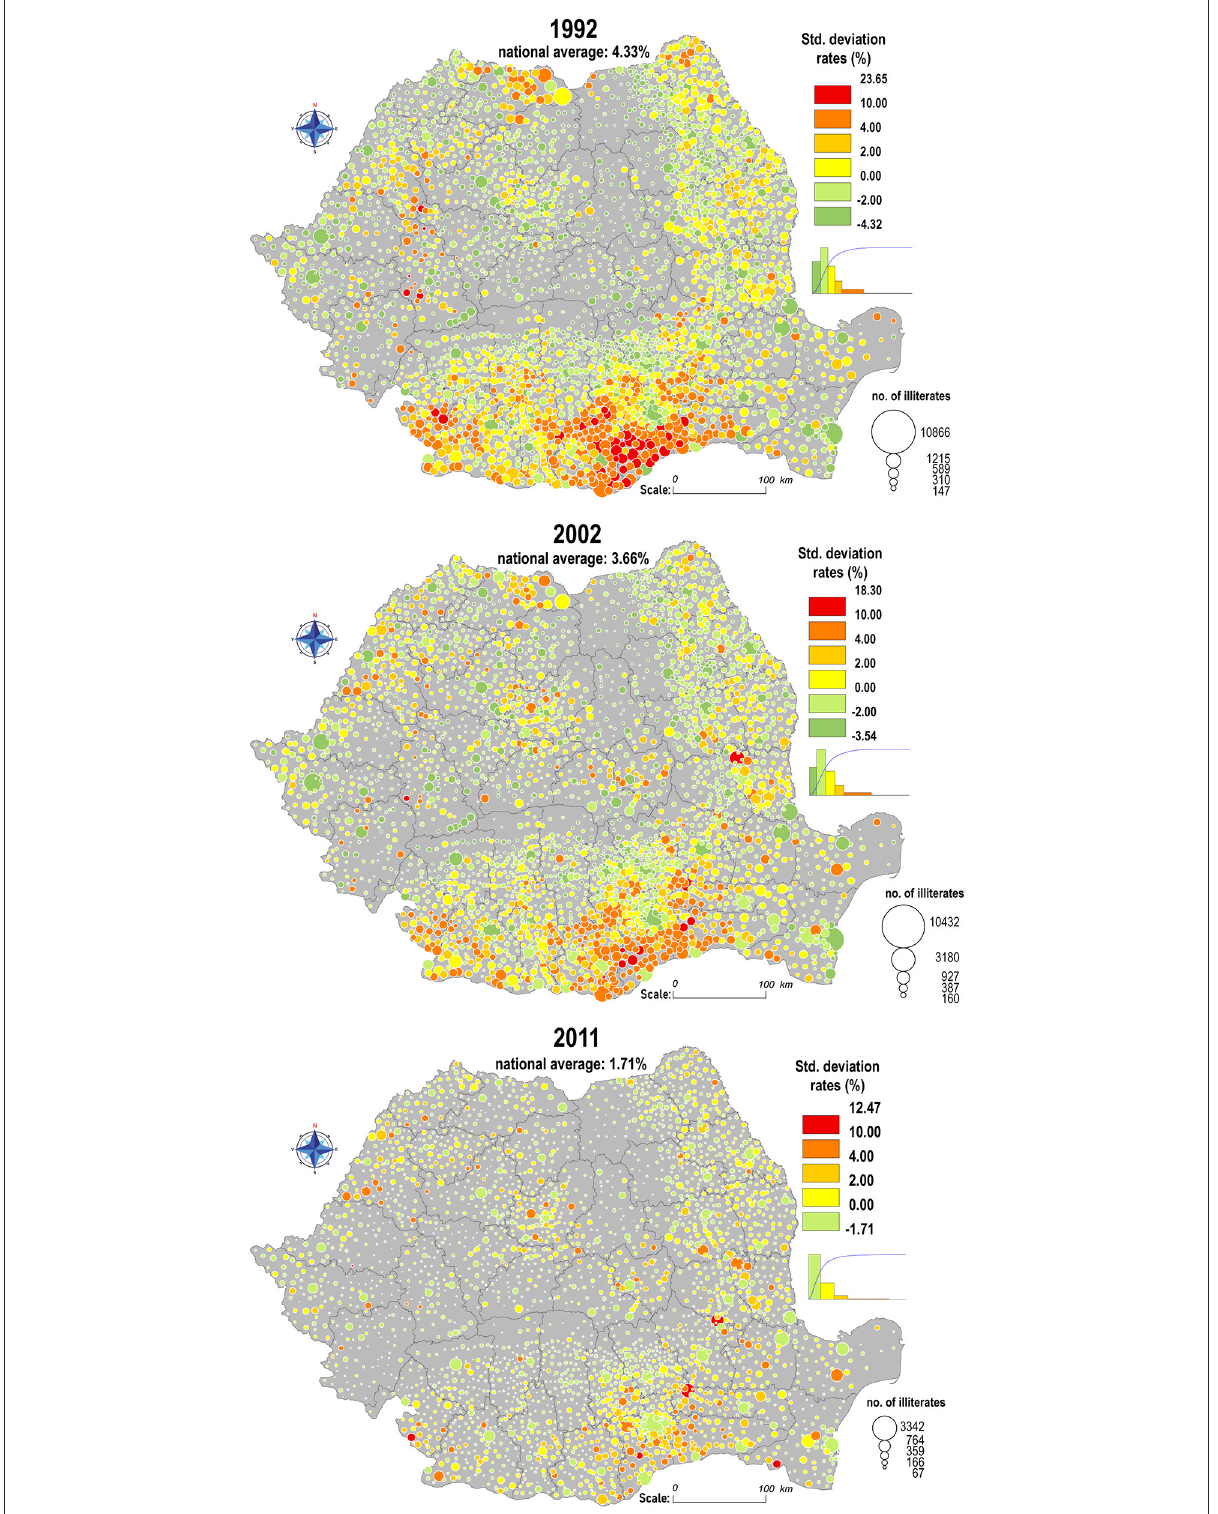
FIGURE2 Spatial distribution of the standard deviations rates from the national average of illiterates according to the 1992, 2002 and 2011